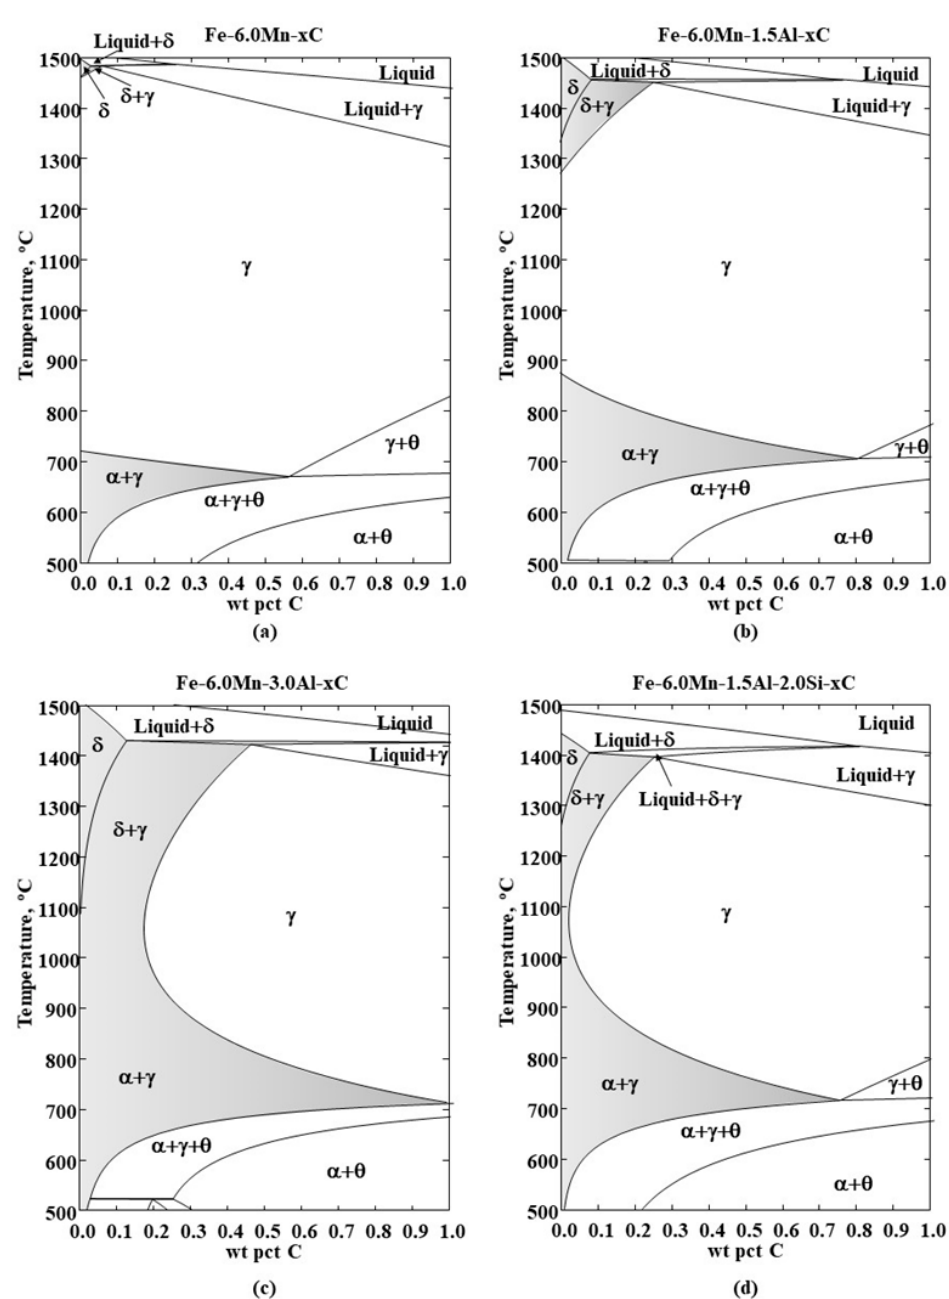
Figure 2. Pseudo-binary phase diagrams for ( a ) Fe–6.0Mn–xC, ( b ) Fe–6.0Mn–1.5Al–xC, ( c